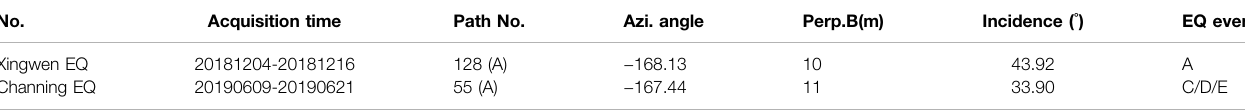
TABLE 3 | Parameters of the Sentinel-1A pairs that were used in this study (A is ascending orbit).